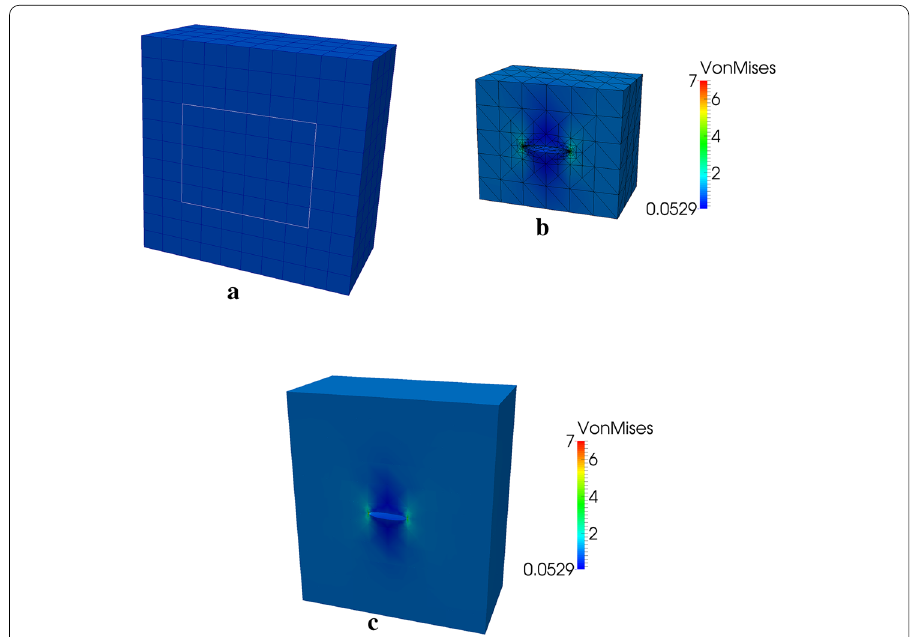
Fig. 17 Von Mises stress at each step of a non-intrusive Abaqus-ISET analysis of a surface crack— a initial global von Mises— b local von Mises— c enriched global von Mises. a Presents the simple stress field without fracture. b Introduces the stress singularity from the surface crack. c Presents (GFEM gl ) transfer of the singular stress state back to the enriched global